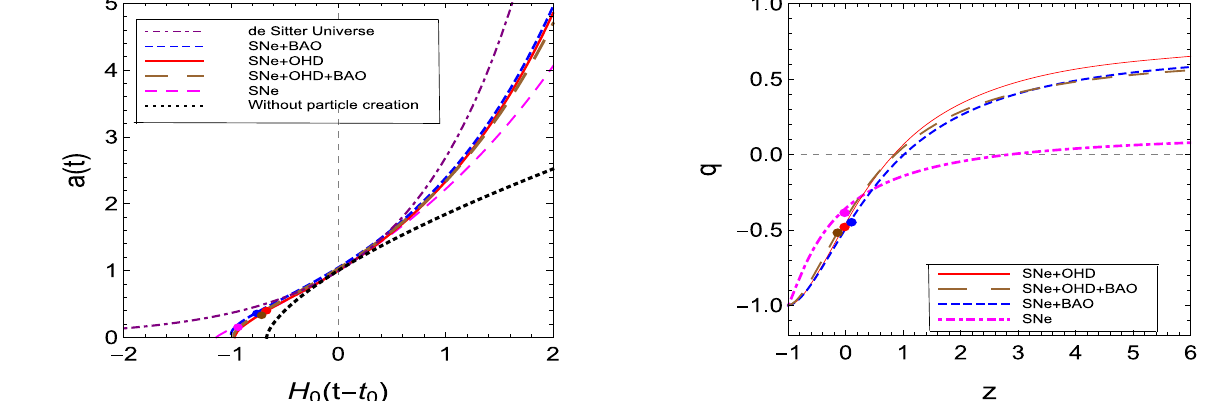
Fig. 5 The scale factor as a function of time. The trajectories show the accelerated expansion after early deceleration for the best-fit val- ues of model parameters obtained from different individual/combined observational data set. The trajectory (dotted curve) is also shown for a matter-dominated model in the absence of matter creation which shows decelerated expansion. A dot denotes the transition point where the transition from decelerated phase to accelerated phase occurs